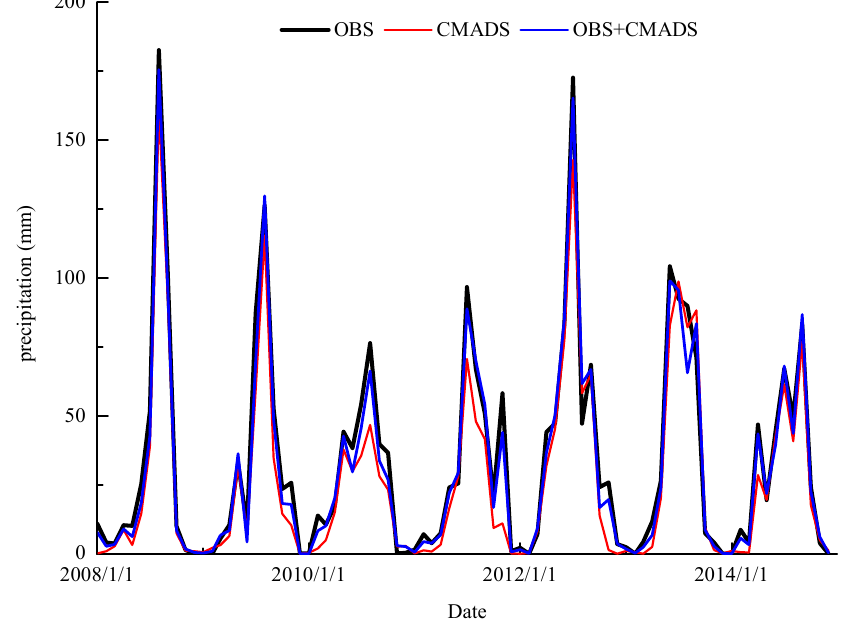
Figure 10. The comparison of monthly precipitation obtained by different precipitation datasets.